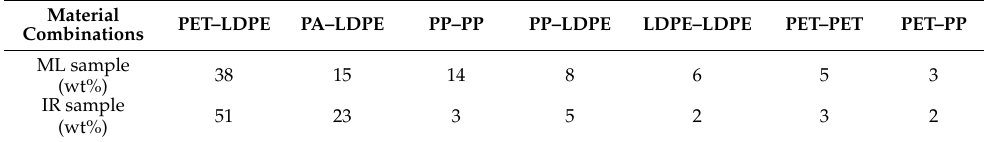
Table 8. Polymer multilayer combinations of the ML sample and IR sample in